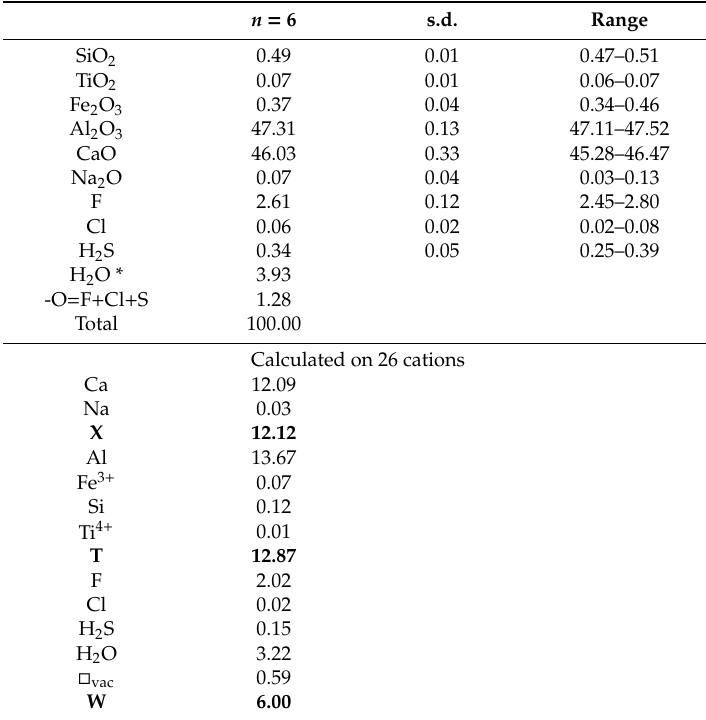
Table 1. Chemical composition of fluorkyuygenite,